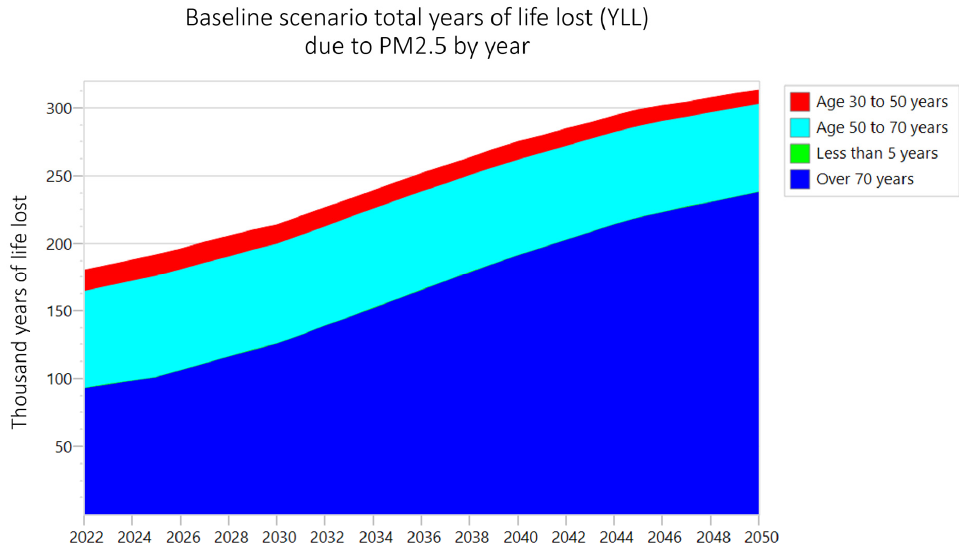
Figure 5. Projected total years of life lost (YLL) by age group due to PM2.5 in baseline scenario.